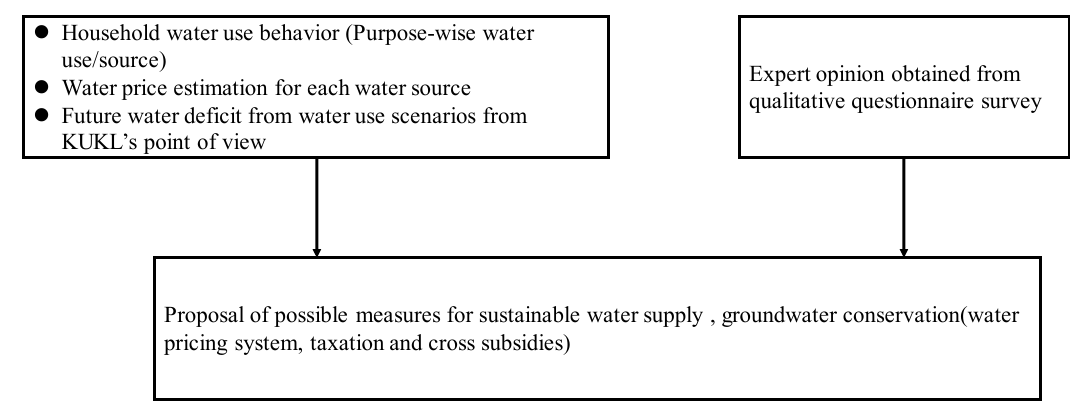
Figure 1. Methodological framework.